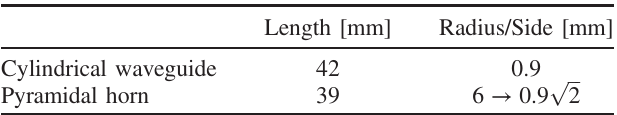
TABLE I. Waveguide internal dimensions.